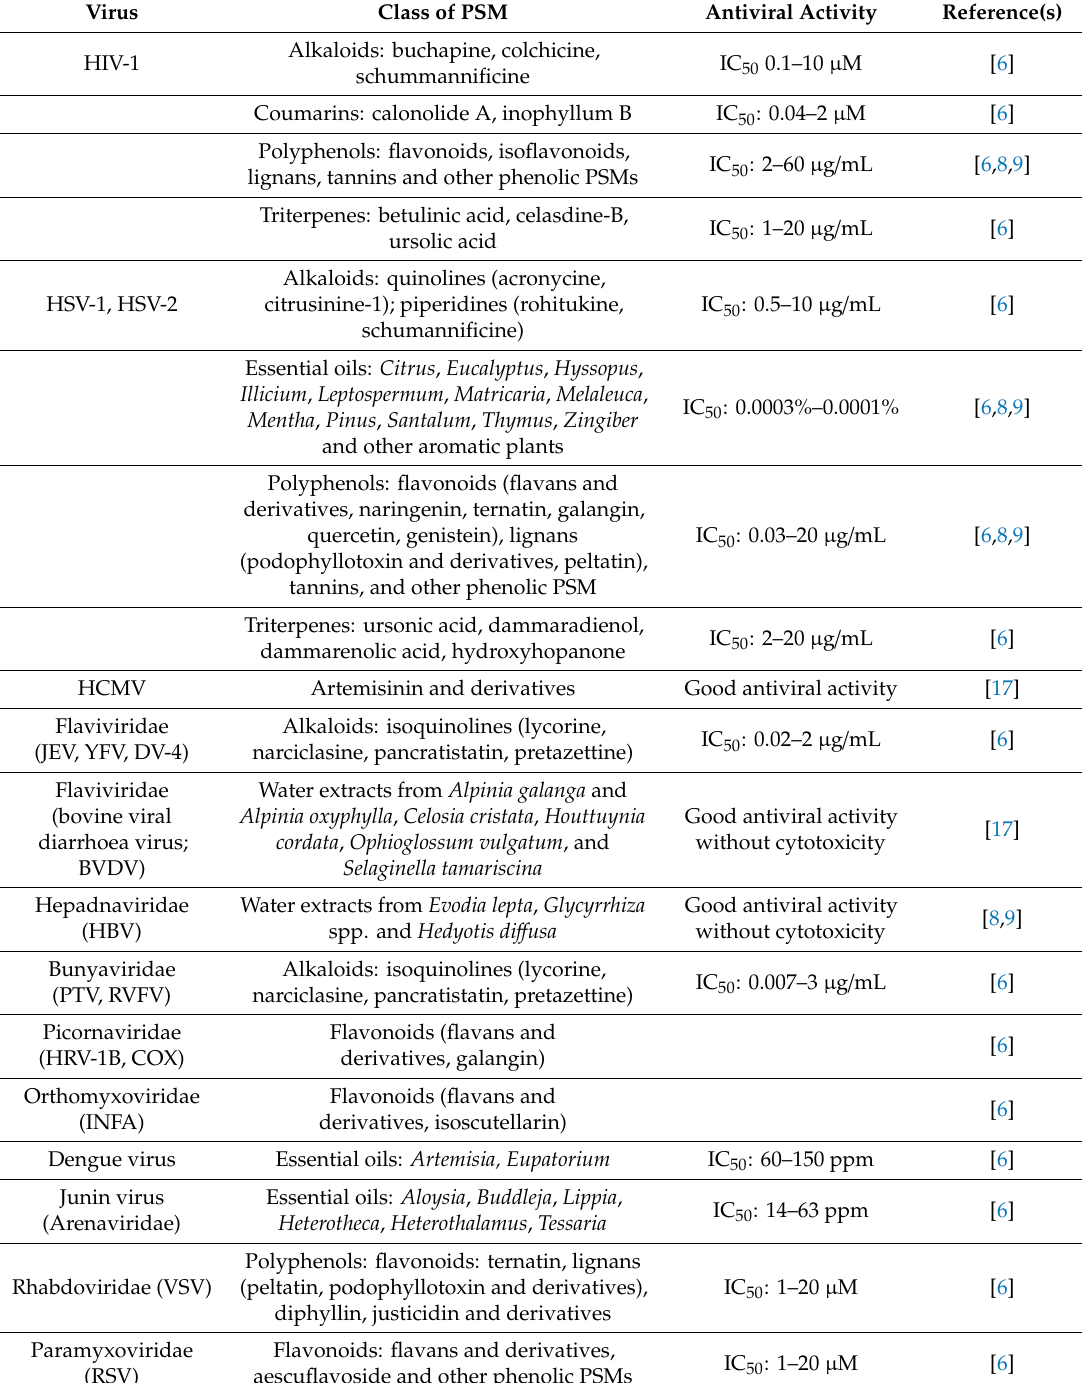
Table 2. Antiviral activity of selected plant extracts or plant secondary metabolites (PSMs) [6,7]. For DNA-intercalating alkaloids, see Table